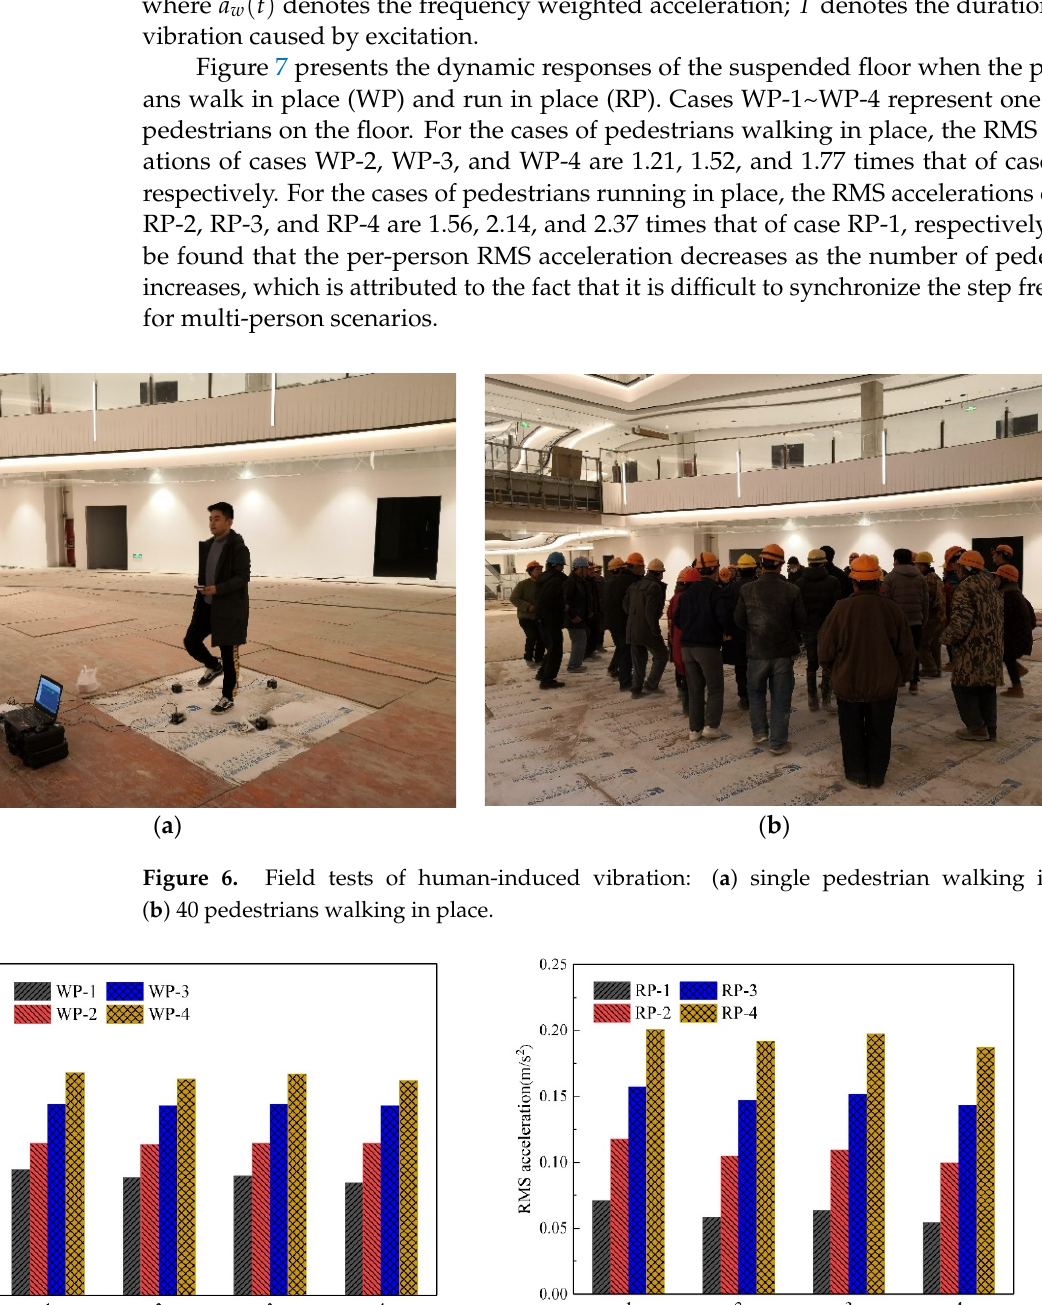
Figure 7. Comparisons of RMS accelerations at different measuring points under human-induced dynamic loads: ( a ) walking in place (1.77 Hz); ( b ) running in place (3.54 Hz).